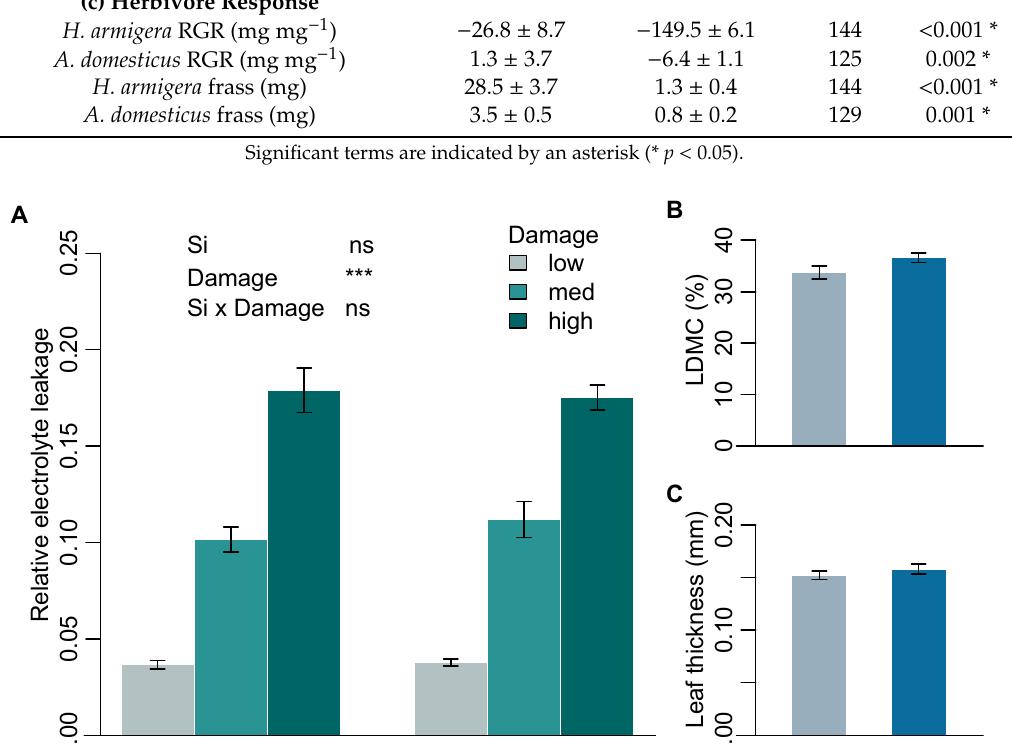
Figure 1. Mechanical leaf traits in response to Si supplementation. ( A ) Relative electrolyte leakage (REL) at three different levels of mechanical damage ( n = 9), ( B ) percent leaf dry matter content (LDMC) ( n = 12) and ( C ) leaf thickness (mm) ( n = 9) of B. distachyon in Si+ and Si- plants. Values are means ± SE. Degrees of significance are indicated as follows: ns = not significant, *** p < 0.001.